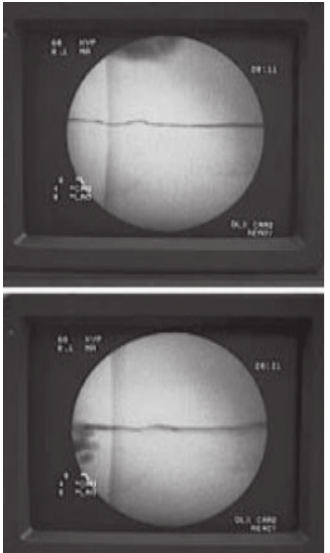
Fig. 3 – Arteriografia: aspecto da artéria radial com injeção de